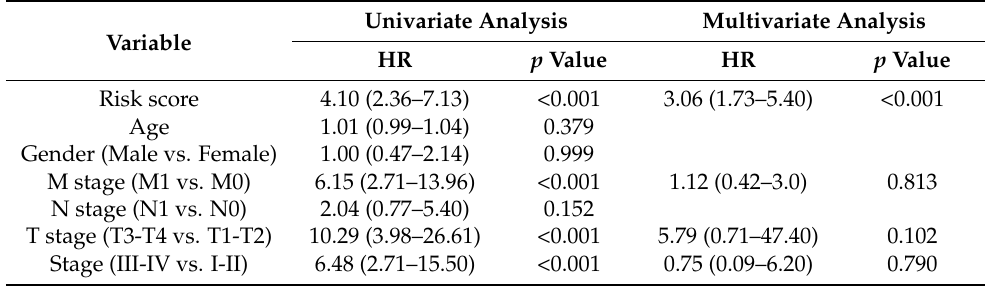
Table 1. The results of univariate and multivariate Cox analyses in TCGA-ACC dataset.